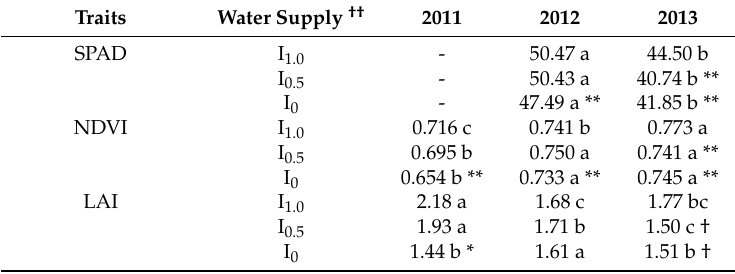
Table 1. Effect of water supply on the spectral traits, leaf area index (LAI) and yield components of sweet